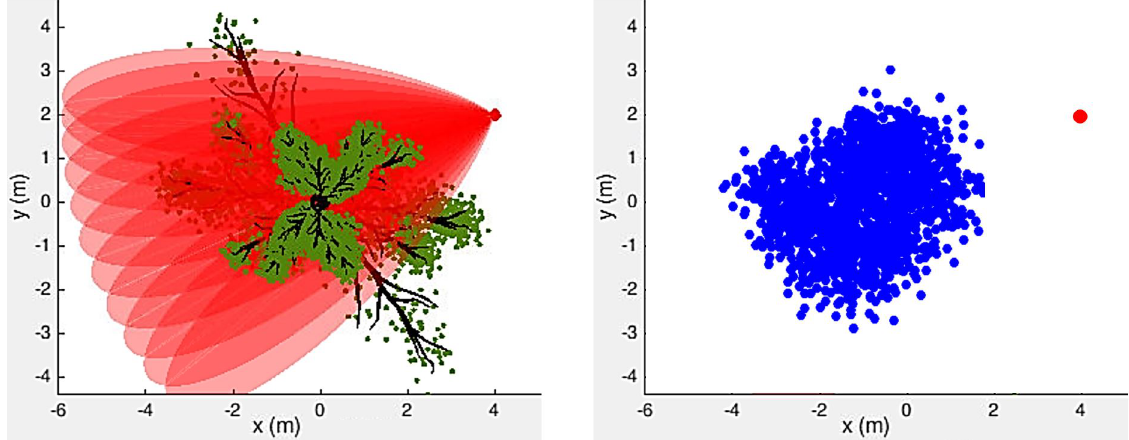
Figure 4. In dense mode—the recorded echo peaks and time span show the number of leaves in the diverse environment—a map is created with x,y positions in